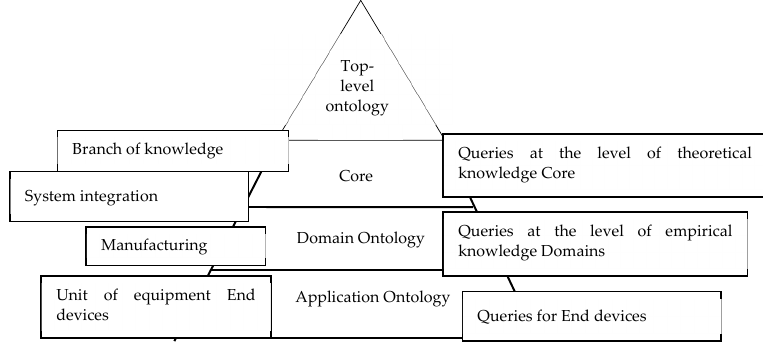
Figure 1. Four-level hierarchy of ontology.